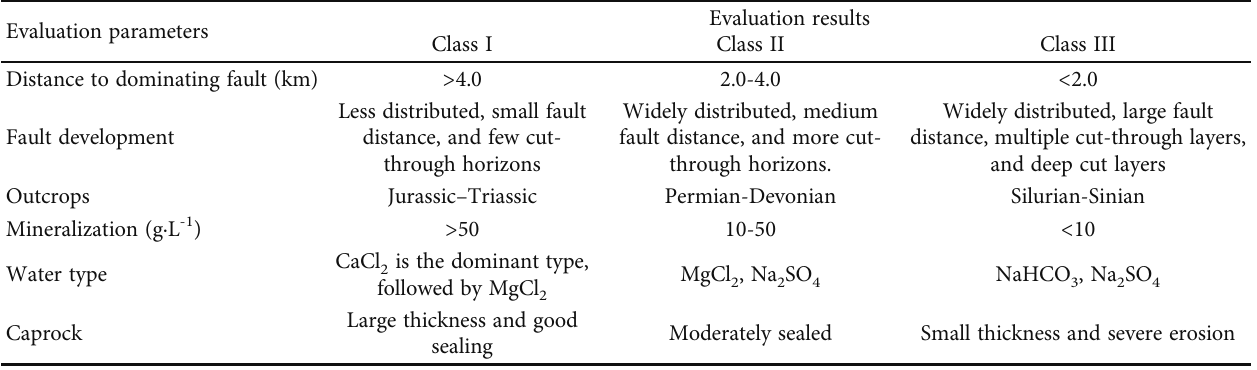
Table 3: The comprehensive evaluation system for hydrocarbon preservation conditions of the Upper Permian formations.